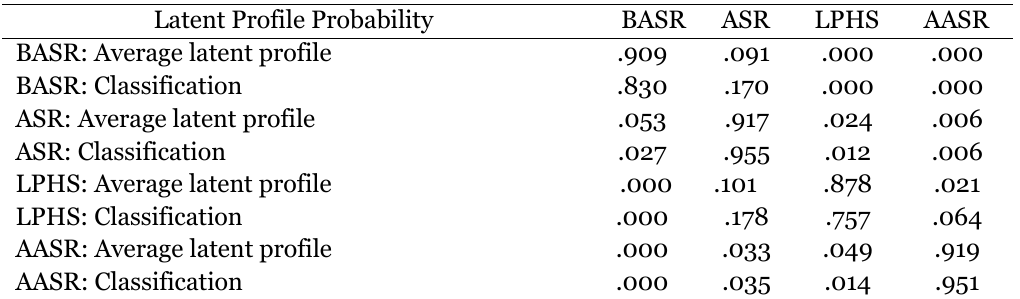
Model 4: Average Latent Profile Probabilities and Classification Probabilities Latent Profile